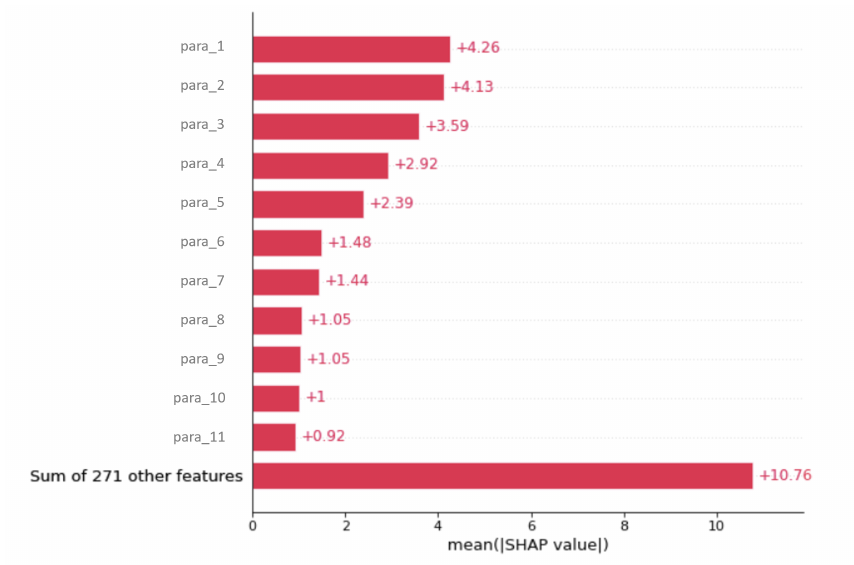
Figure 5. SHAP feature importance of ET model for the training data set. After pre-processing (polynomial feature engineering) of input features, the number of features increased from 51 to